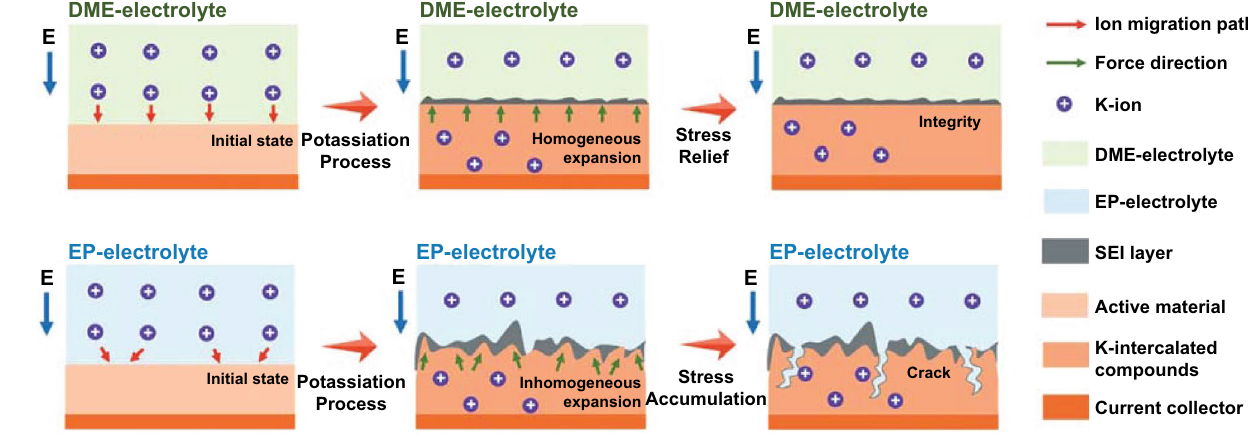
Fig. 5 Schematic illustration of expansion process of electrodes in DME- and EP-based